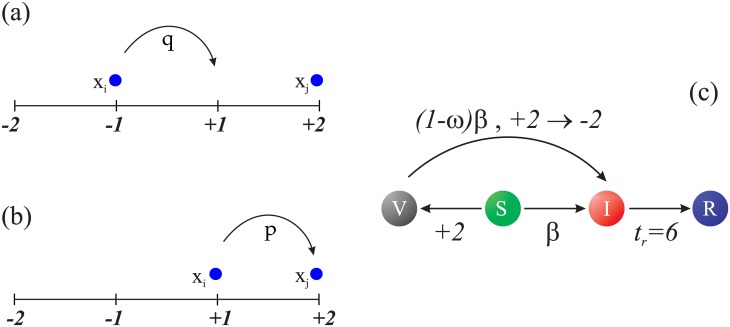
Simplified scheme of opinions and epidemics dynamics.Left figures illustrate the opinion dynamics, when two nodes have opinion states with different sign, one of them approaches its state to the opinion of the other with a probability q (a), whereas if the sign is the same the node reinforces its opinion with probability p (b). Right figure illustrate the contagion dynamics, a susceptible individual S (green) is infected (red) with probability β and after a time tr he recovers (blue). A S becomes vaccinated V (gray) when he acquires a state of opinion 2, but then he can become I with a probability (1 − ω)β, changing his opinion to −2.